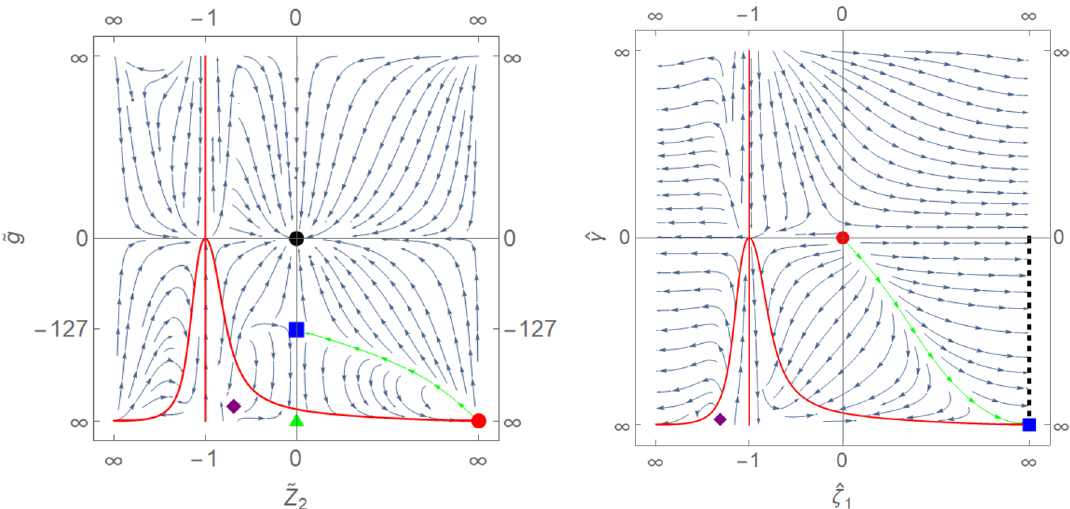
Figure 1 . The flow in the chart U 1 (left) and in the chart U 2 (right). The black dot (on the left) and the dahed black line (on the right) mark GFP 1 , the red dot marks GFP 2 , the blue square marks NGFP 1 . The separatrix is the green flow line. The continuous red lines are singularities of the